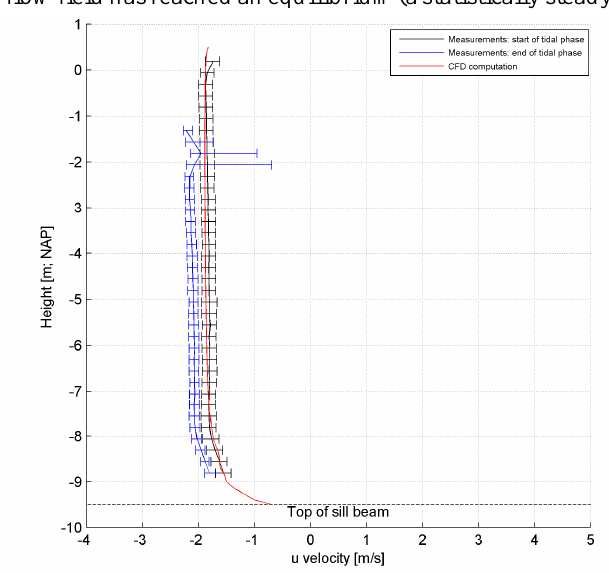
Fig. 7 Vertical ADCP profile from the measurements without turbines (in blue) and the CFD (in red) – Ebb Case